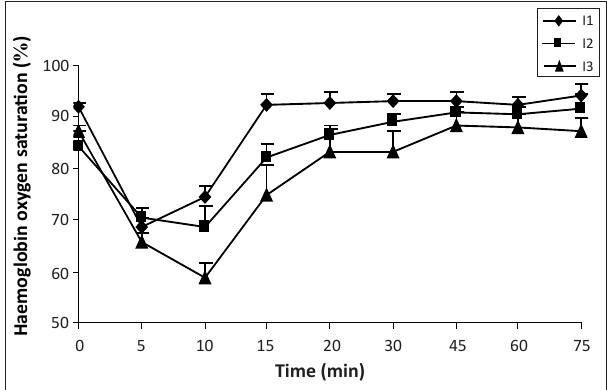
FIGURE 9: Mean ± standard error of central venous pressure (cm H buffaloes of different groups.